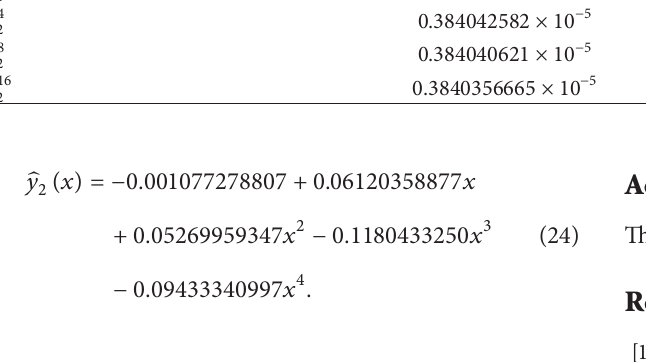
Table 4: Approximations for 𝑦(𝑥) + ∫